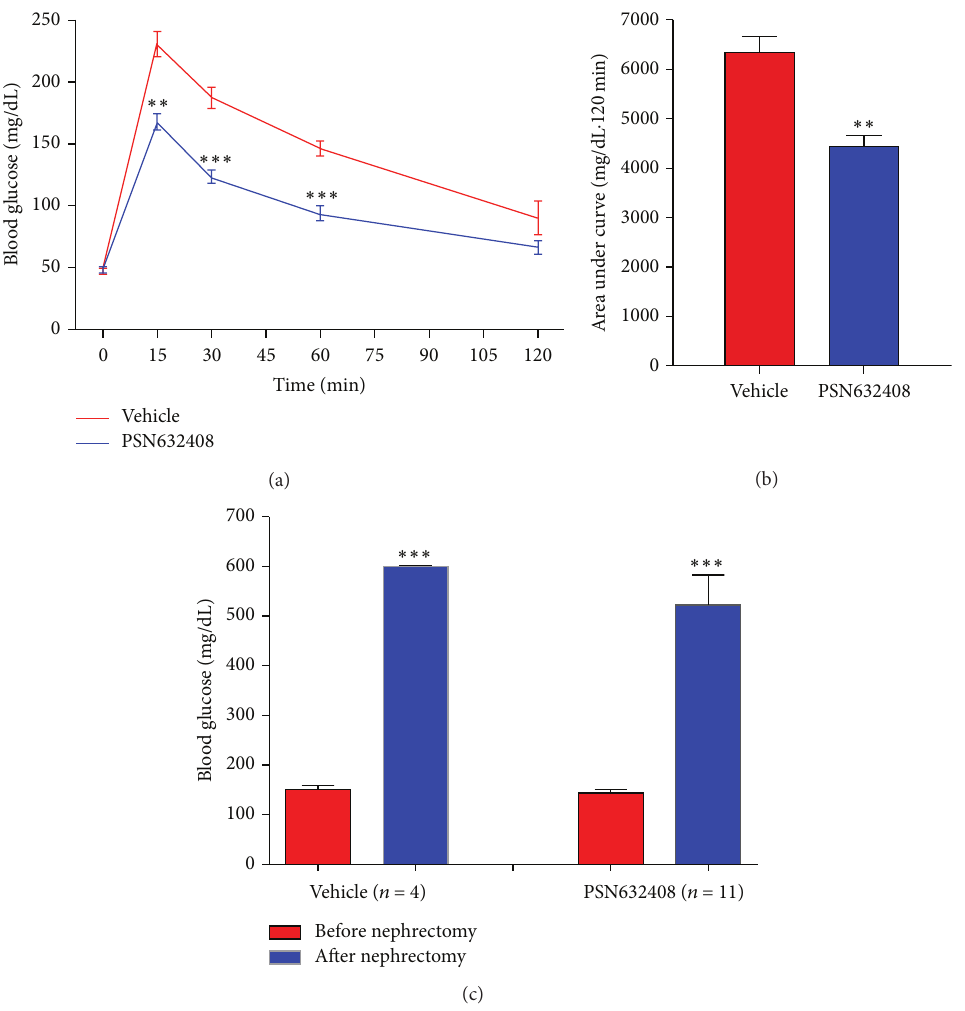
Figure 2: (a) OGTT in PSN632408- or vehicle-treated diabetic mice with normoglycaemia at 4 weeks after transplantation. PSN632408- treated mice ( 𝑛 = 9 ) had significant decreases in glucose levels compared with vehicle-treated mice ( 𝑛 = 4 ) after glucose challenge ( ∗∗ 𝑃 < 0.002 , ∗∗∗ 𝑃 < 0.001 ). (b) Area under curve (AUC 0 – 120 ) during OGTT. AUC 0 – 120 was significantly decreased in PSN632408-treated mice ( 𝑛 = 9 ) compared with vehicle-treated mice ( 𝑛 = 4 ) ( ∗∗ 𝑃 < 0.002 ). (c) Blood glucose levels in PSN632408 ( 𝑛 = 9 ) or vehicle-treated diabetic mice ( 𝑛 = 4 ) with normoglycaemia before and after removal of left kidney bearing human islet grafts ( ∗∗∗ 𝑃 < 0.001